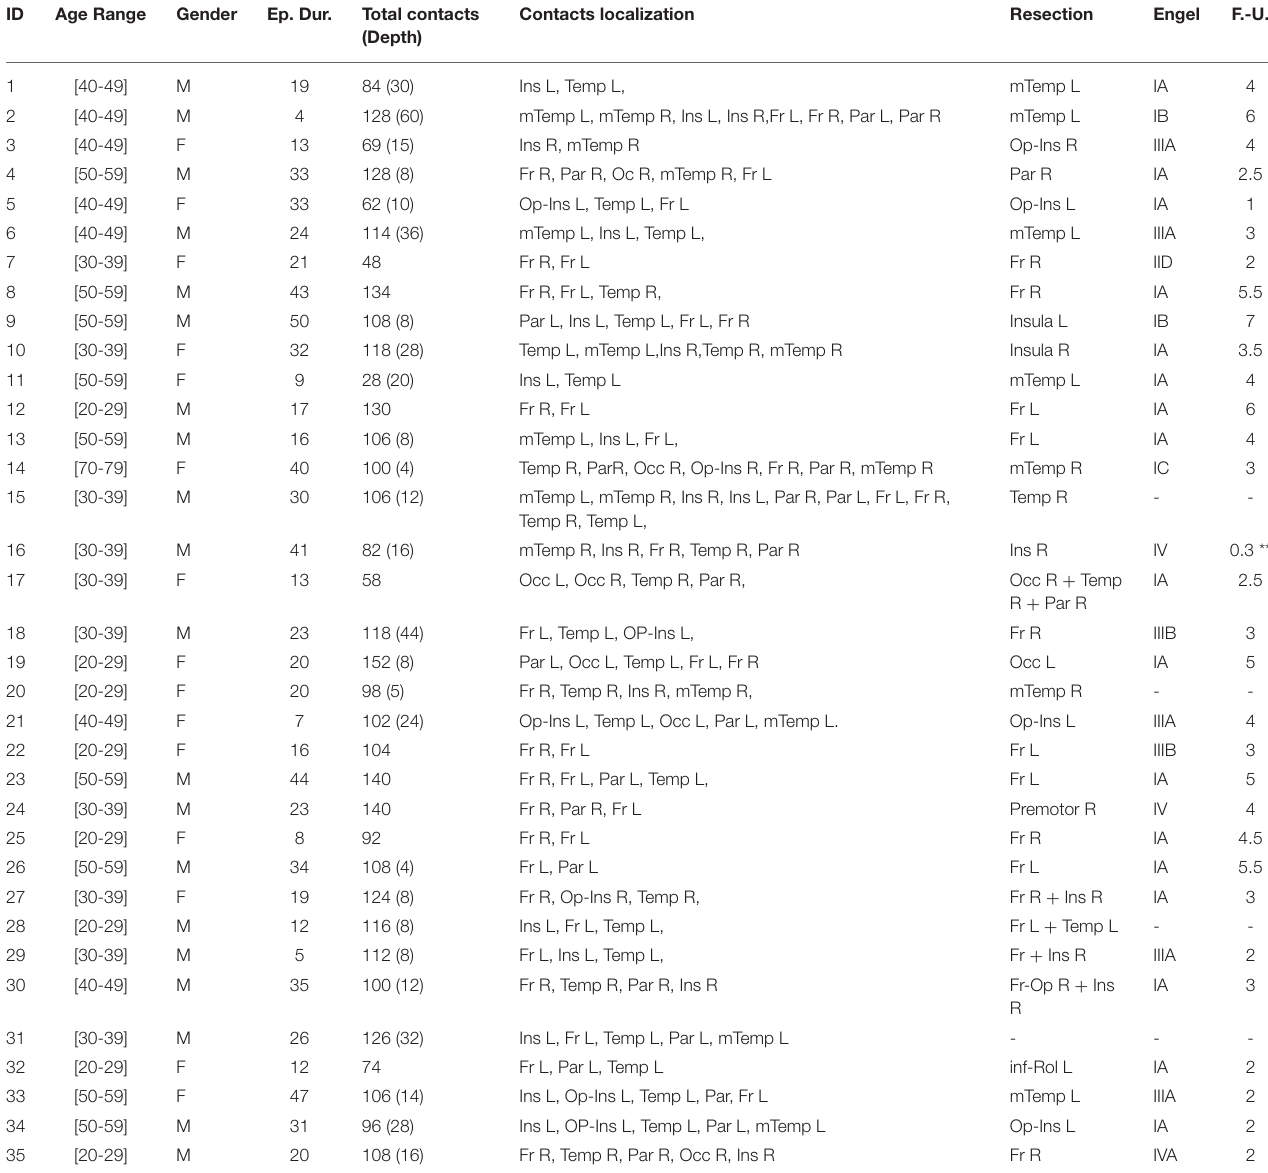
TABLE 1 | Demographic and clinical characteristics of patients. ID Age Range Gender Ep. Dur. Total contacts Contacts localization Resection Engel F.-U. (Depth)